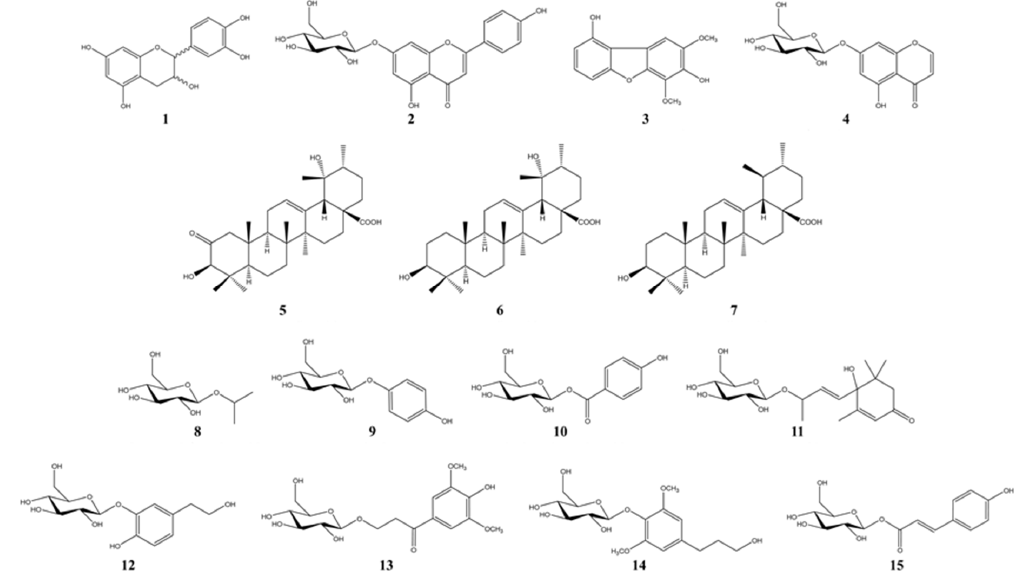
Figure 4. Chemical structures of compounds isolated from PAL.